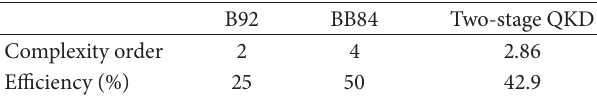
Table 5: Comparison of complexity order and efficiency of B92, BB84, and two-stage QKD